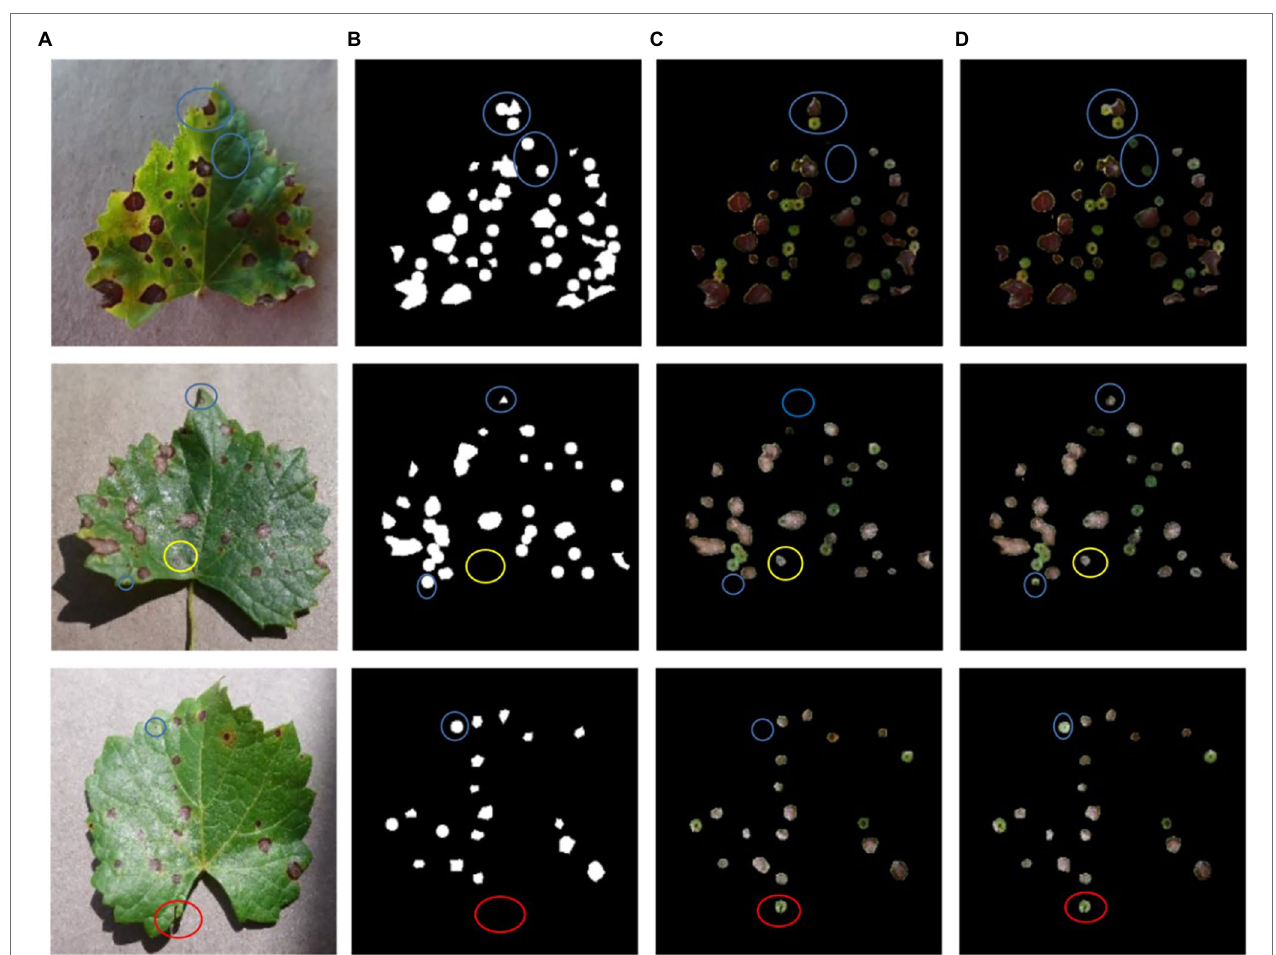
FIGURE 8 | A comparison of network training results before and after DeepLab v3+ improvement. (A) The original image, (B) the manually labeled and segmented image, (C) the DeepLab v3+ segmentation results, (D) the improved DeepLab v3+ segmentation